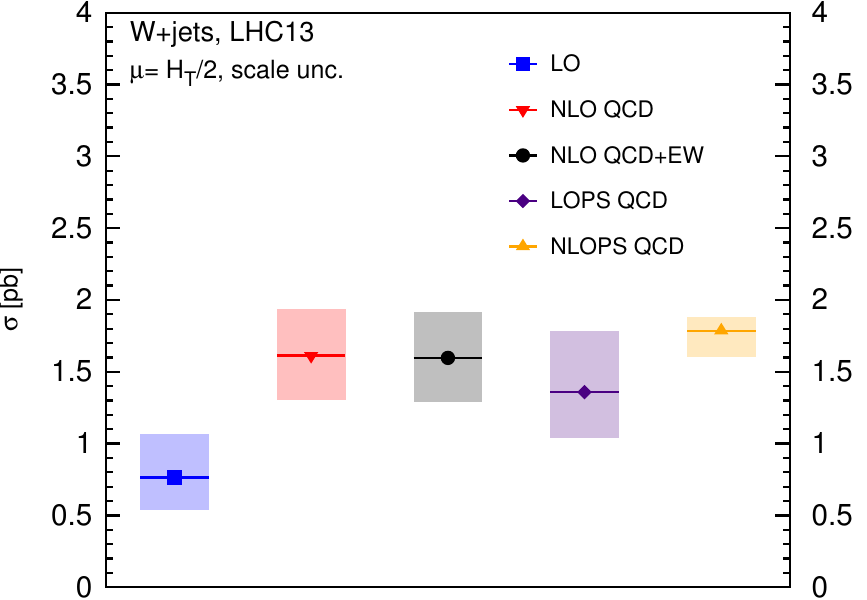
Figure 8 . W +jets cross sections and their uncertainties from scale dependence in the (cid:12)ducial region in di(cid:11)erent approximations. Corresponding numbers are listed in tables 2 and